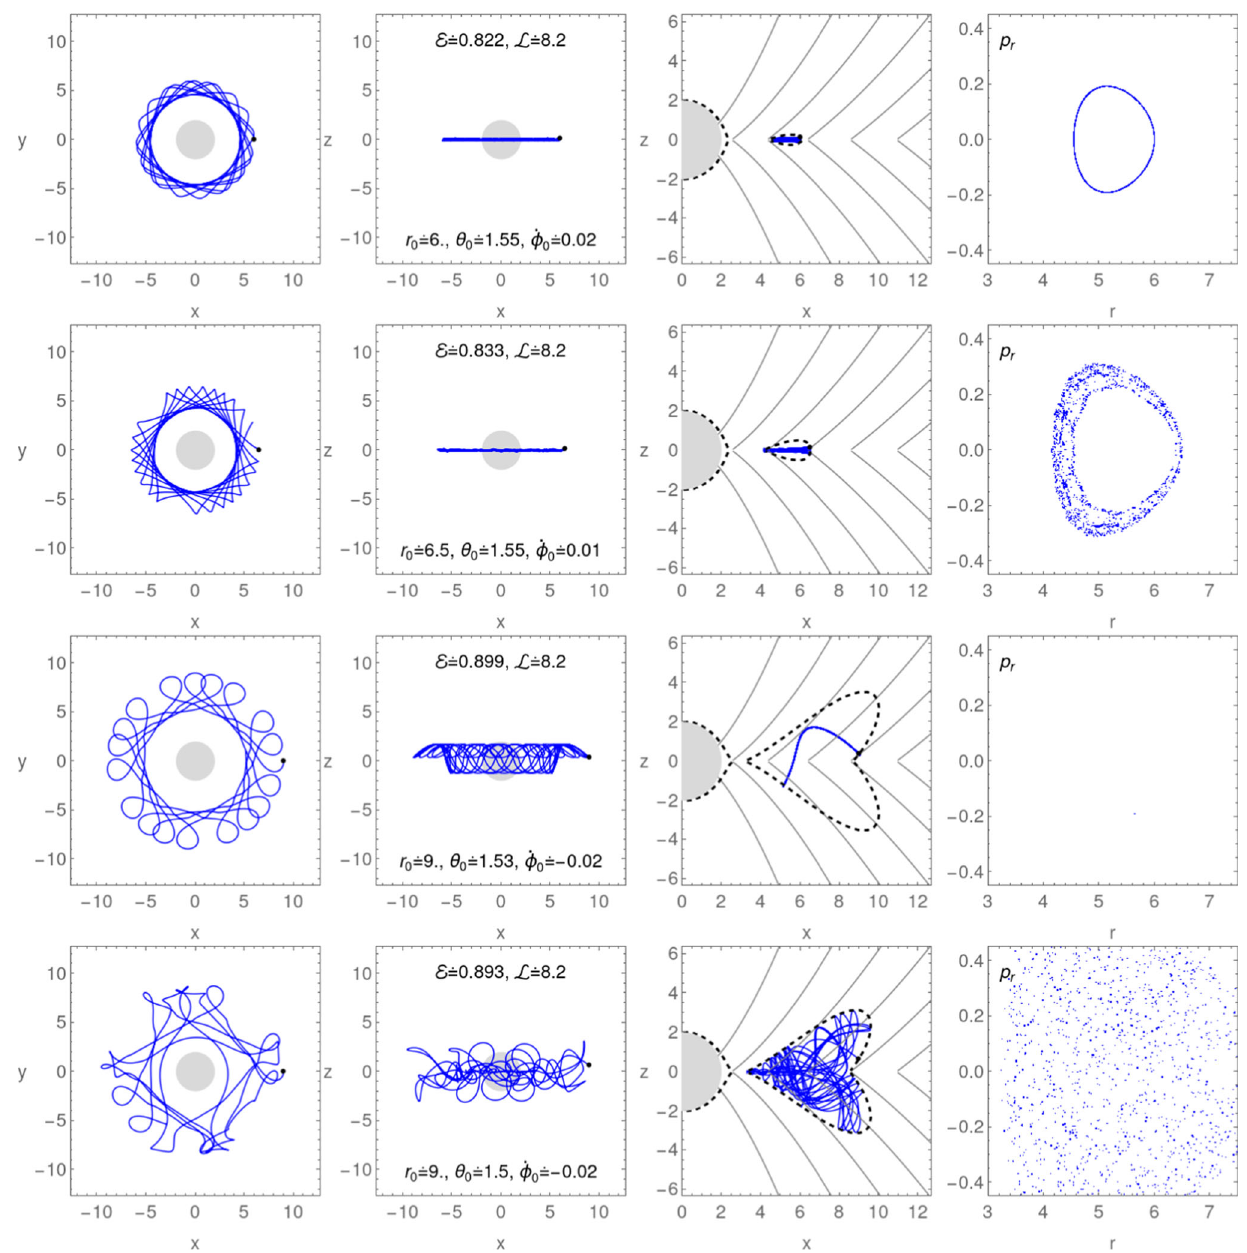
Fig. 9 Charged particle chaotic dynamics (blue curve) in parabolic MF (gray parabolic lines) around BH (gray circle) can be well demon- strated by the PS plots (last column). In the first row, we see complete regular motion represented by smooth the Kolmogorov–Arnold–Moser (KAM) torus section. In the second row, we observe that this KAM torus is already starting to break and chaos is emerging with this orbit.